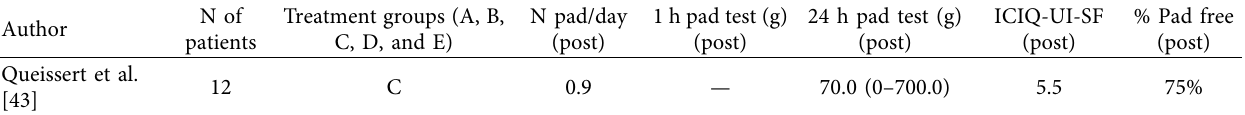
standardized mean difference (SMD) of number of pad/day (a), ICIQ-SF score (b), and for continence event rate recovery (c) at follow-up. Supplementary Figure 3. Meta-regression plots in relation to standardized mean difference (SMD) for the number of pad (a), ICIQ-SF score (b), and for continence event rate (c) recovery at follow-up. Supplementary Table